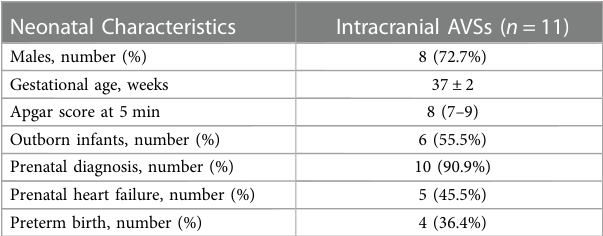
TABLE 1 Neonatal characteristics.